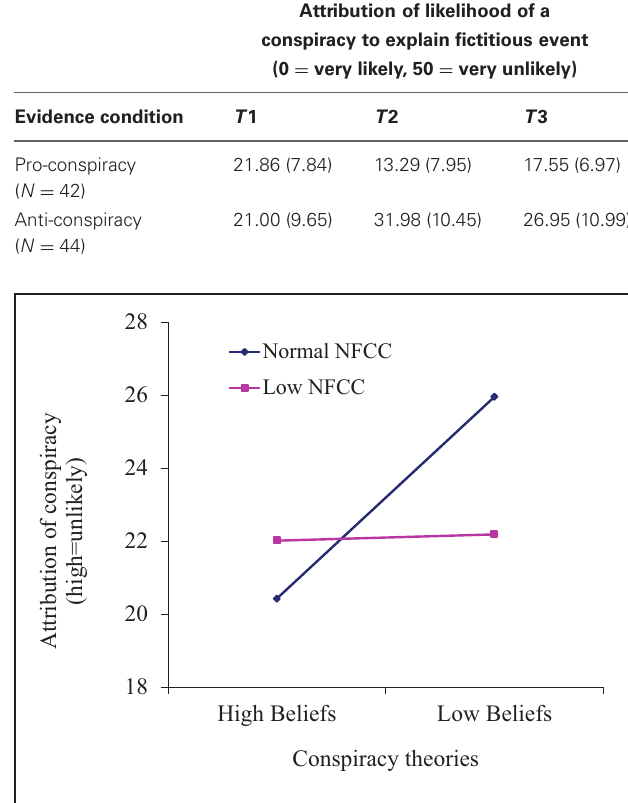
FIGURE 1 | Mean likelihood attribution score at time t 2 (after reading evidence) by NFCC and beliefs in conspiracy